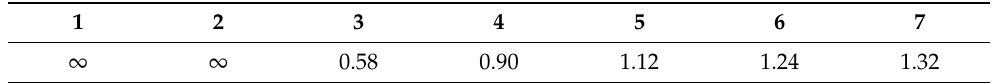
Table 1. Random consistency index (RI) values